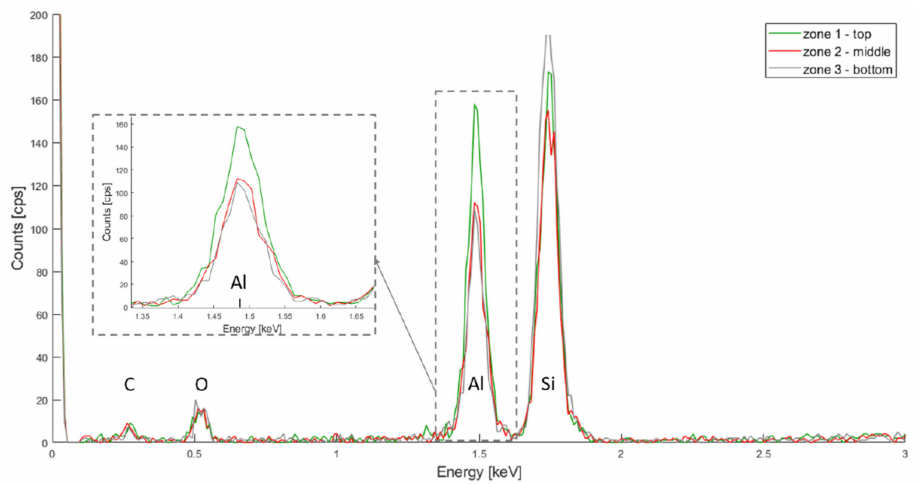
Figure 6. PSiO 2 /Al 2 O 3 EDX spectra for the top, middle and bottom of the porous